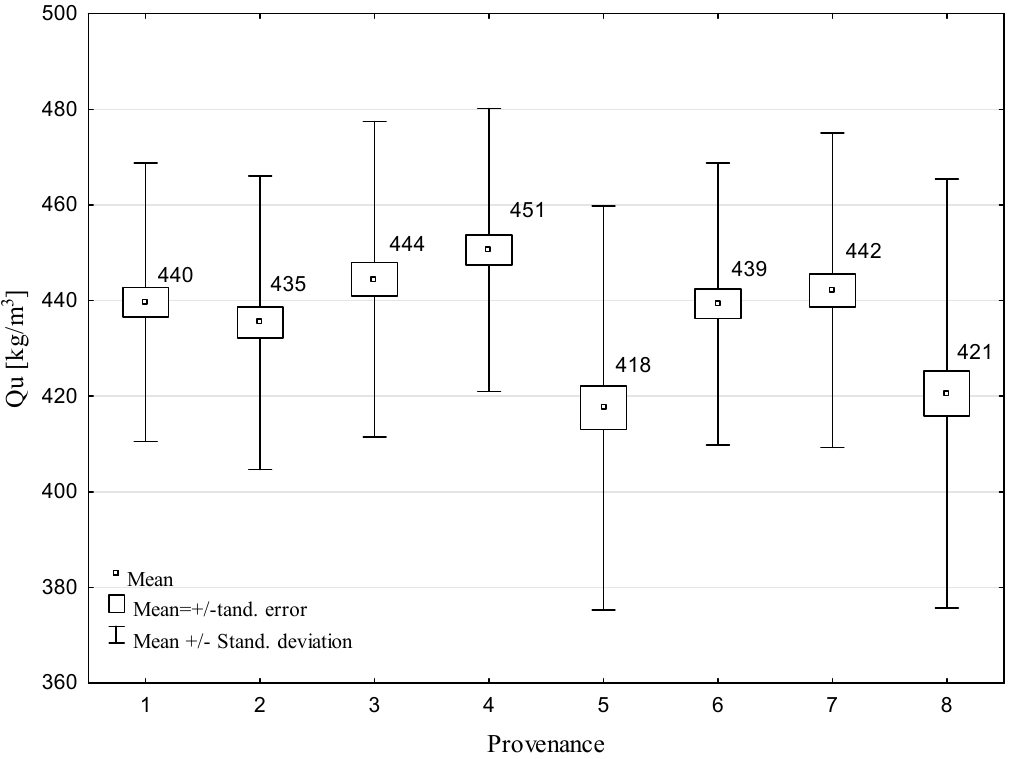
Figure 3. Relative wood density (Qu kg/m 3 ) of the Scots pine ( Pinus sylvestris L.) from various provenances in Poland (1—Woziwoda; 2—Rospuda; 3—Dluzek; 4—Zielonka; 5—Gleboki B.; 6—Radawnica; 7—Bartel W; 8—Lipowa).